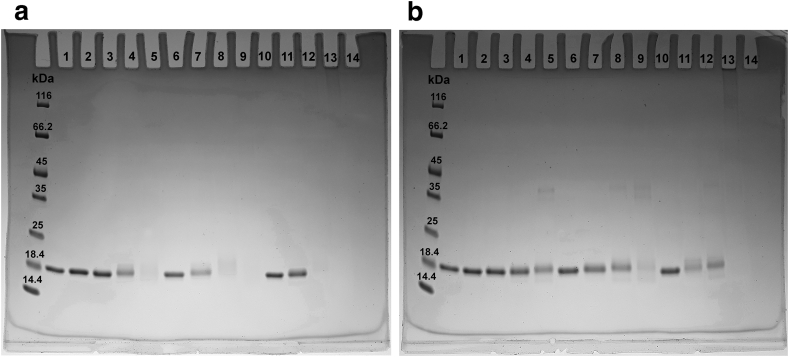
SDS-PAGE electrophoresis performed on the apo-SOD1SH (a) and E,Zn-SOD1SH (b) incubated with MG. Lane 1: control; lane 2: no MG, 5 h; lane 3: 1 mM MG, 5 h; lane 4: 5 mM MG, 5 h; lane 5: 30 mM MG, 5 h; lane 6: no MG, 24 h; lane 7: 1 mM MG, 24 h; lane 8: 5 mM MG, 24 h; lane 9: 30 mM MG, 24 h; lane 10: no MG, 48 h; lane 11: 1 mM MG, 48 h; lane 12: 5 mM MG, 48 h; lane 13: 30 mM MG, 48 h.